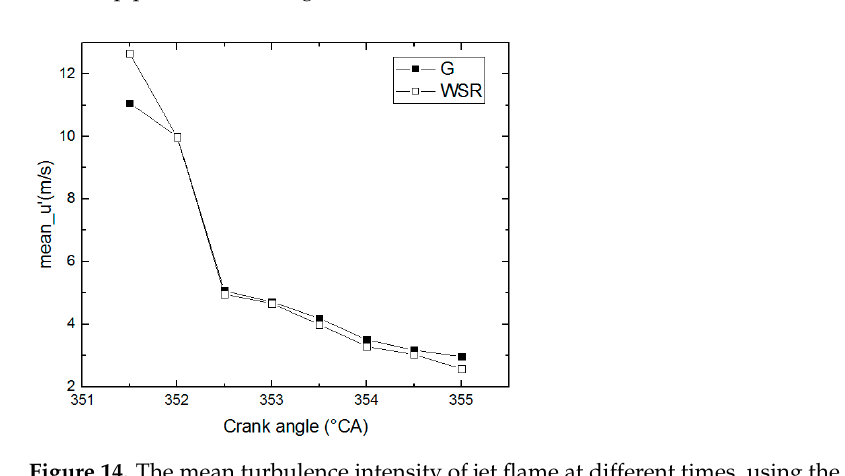
Figure 13. Formation rate of methyl for major reactions that account for more than 1% at 353.8 °CA in the clip plane, same as Figure 12.